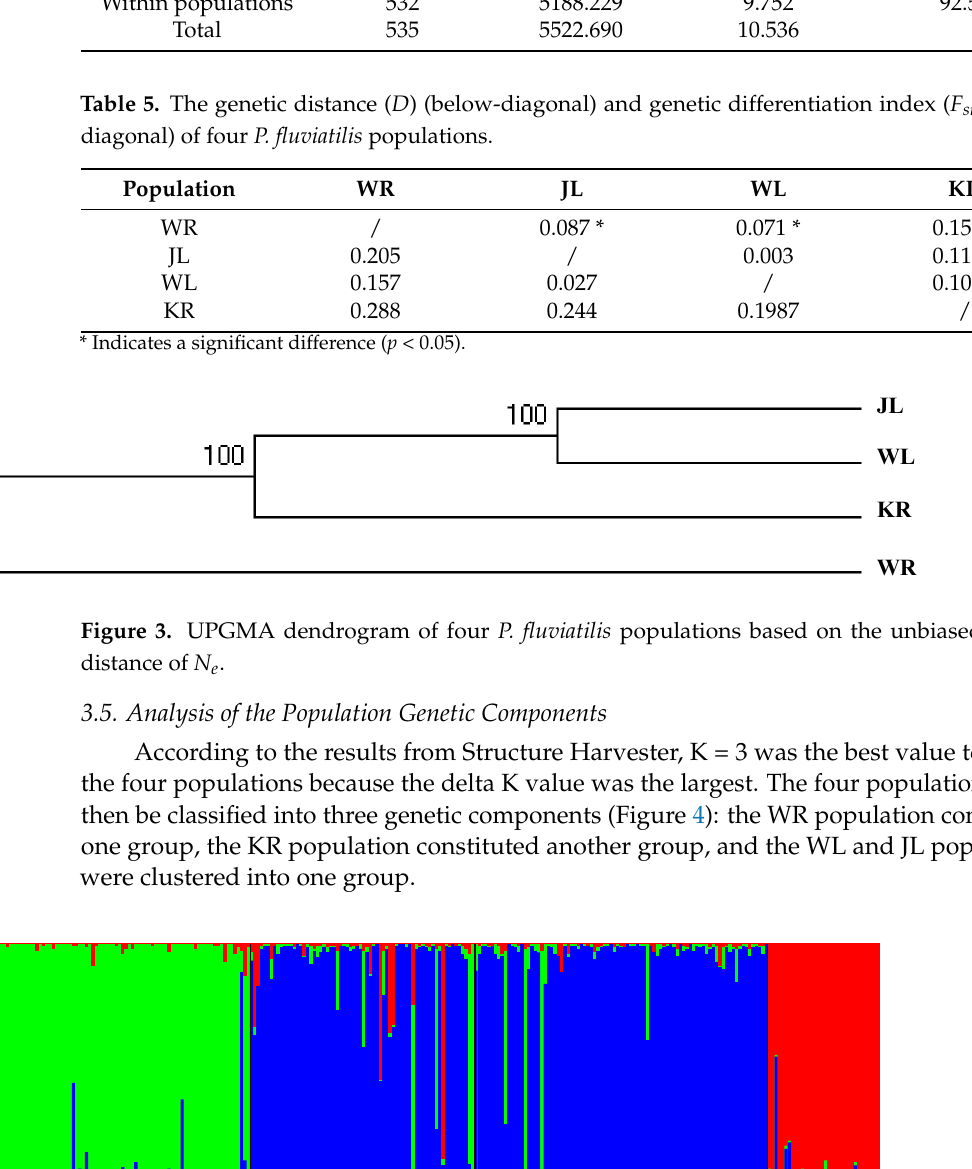
Table 4. Results of the AMOVA based on 29 microsatellite markers. Degree of Variance Source of Variation Squares